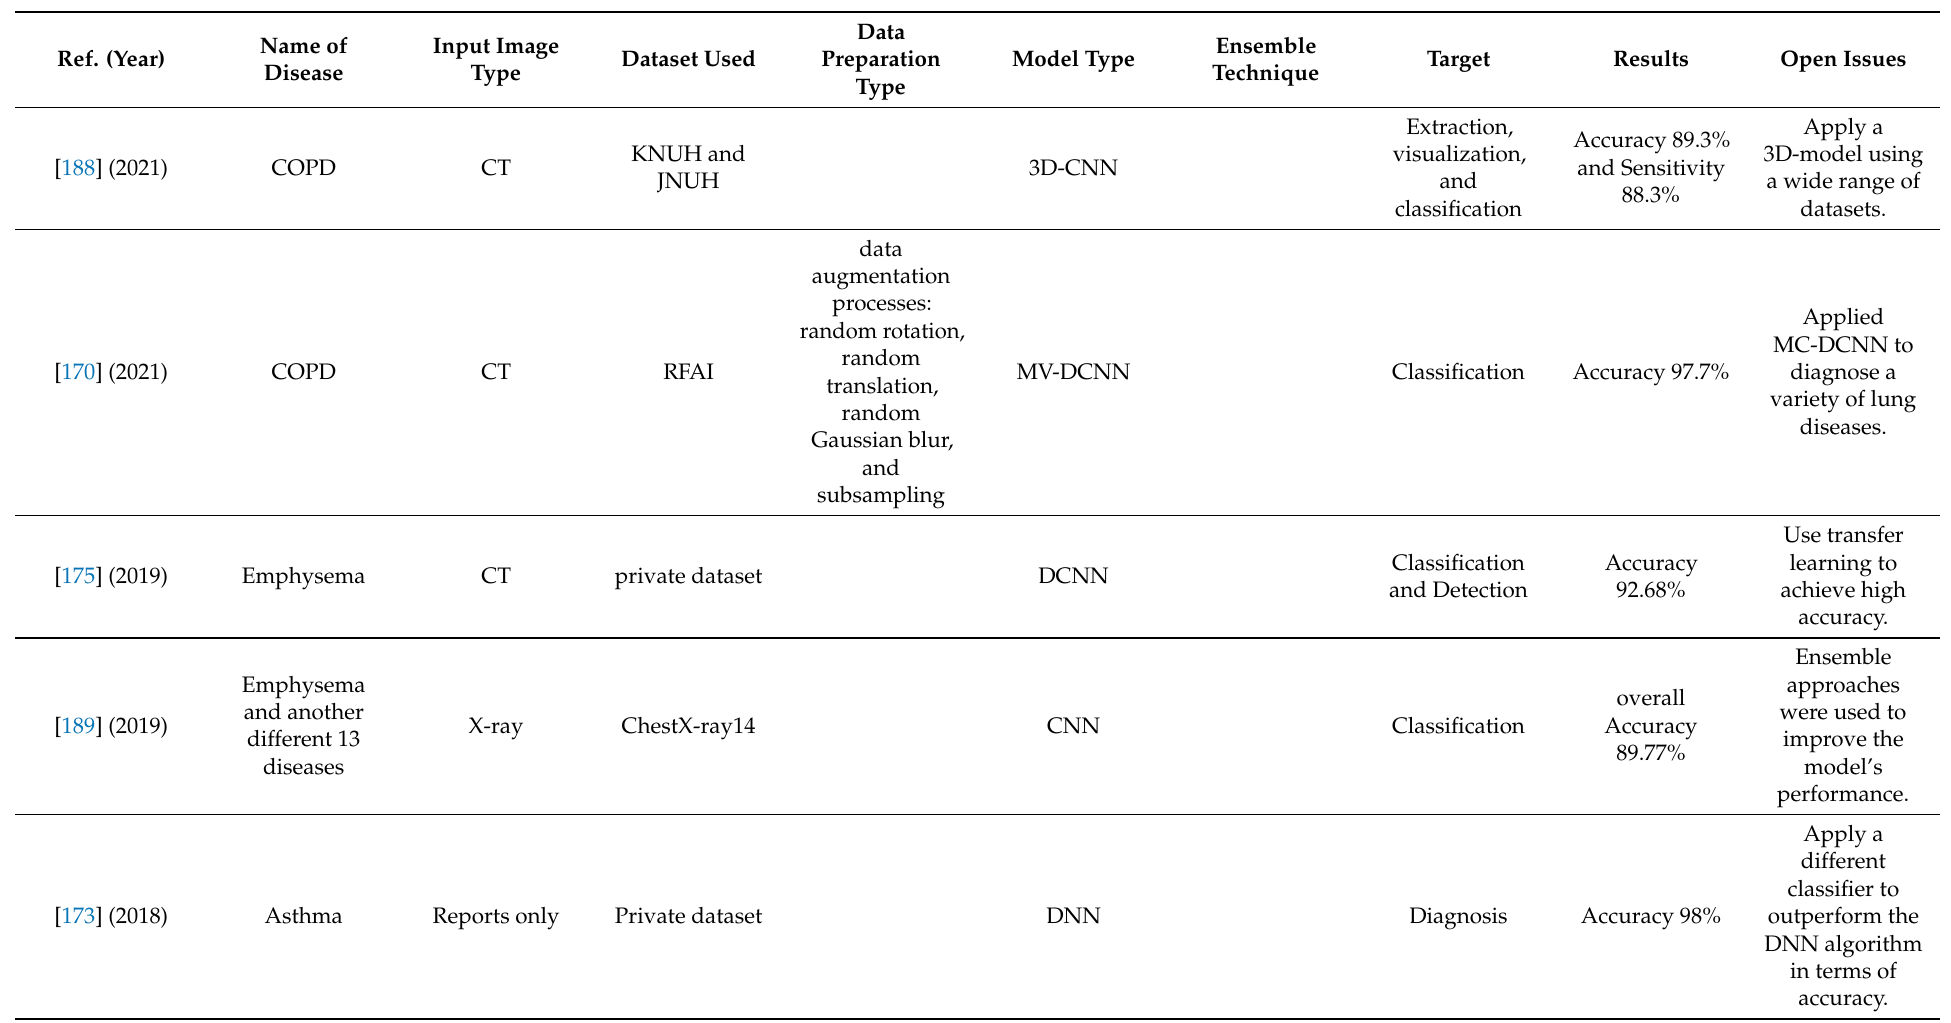
Table 4. Lung diseases detection summary that affect